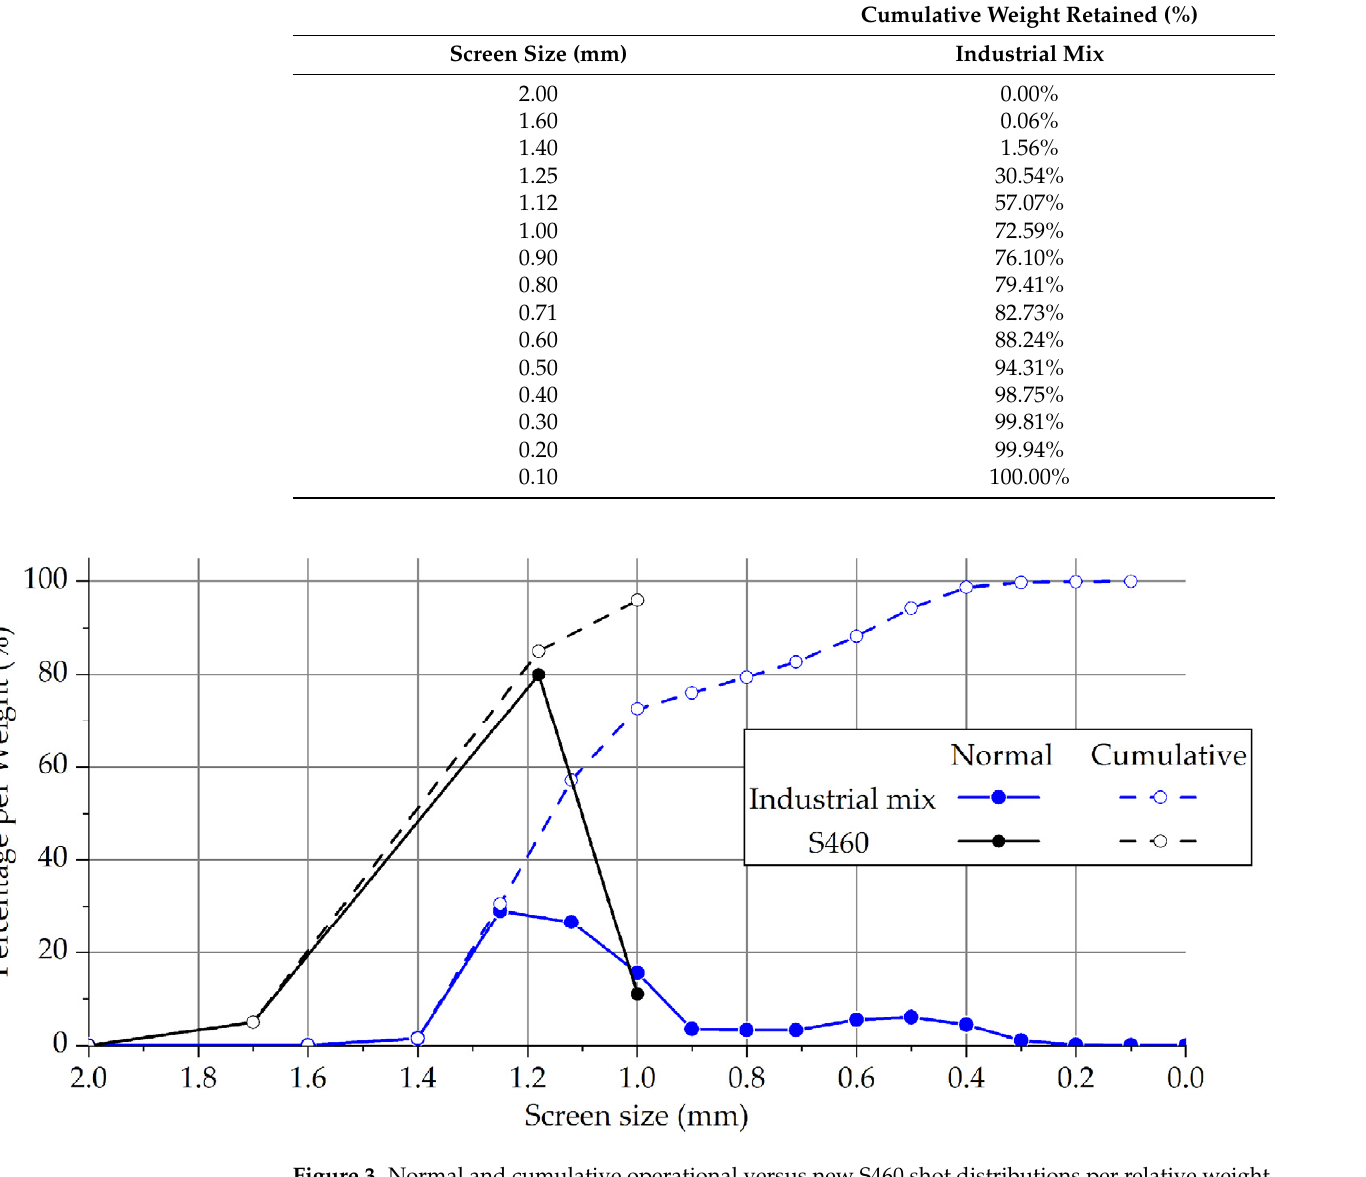
Figure 3. Normal and cumulative operational versus new S460 shot distributions per relative weight.